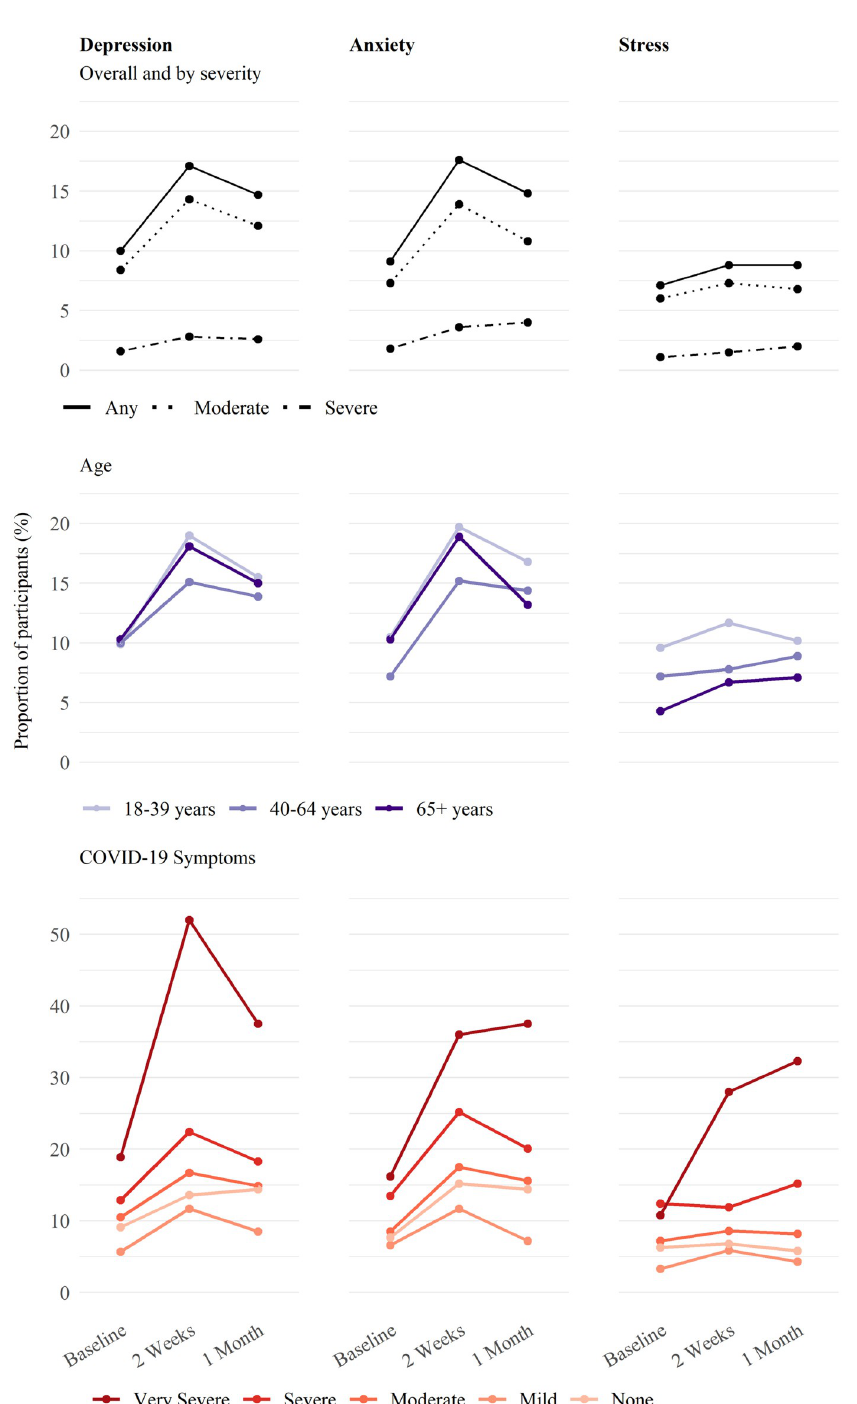
Fig 1. Mental burden of isolation—Negative emotional states in the first month after positive SARS-CoV-2 test result. Proportion of the population reporting symptoms of depression, anxiety, or stress through self-reported questionnaire at 3 different timepoints; before being diagnosed with SARS-CoV-2 infection, during isolation and 30 days after diagnosis, when isolation has ended. Results are reported overall and by symptom severity (i.e., moderate or severe), as well as stratified by age groups and subgroups of self-reported COVID-19 symptoms at infection. Out of 1105 participants, 1095 (99%) completed the baseline questionnaire, 964 (87%) completed the week two and 1050 (95%) the one-month questionnaire. We excluded 26 (2 � 3%) individuals due to large time differences between the positive test result and completion of the baseline questionnaire. The week two questionnaire was not available for 141 participants due to late